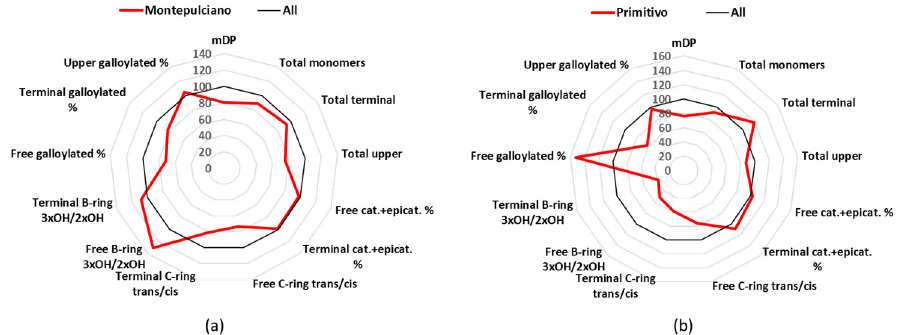
Figure 4. Radar graph comparing the percentage of the relative mean values of Montepulciano ( a ) and Primitivo ( b ), with the mean values of the 12 groups considered as 100%. cat.: catechin, epicat: epicatechin.